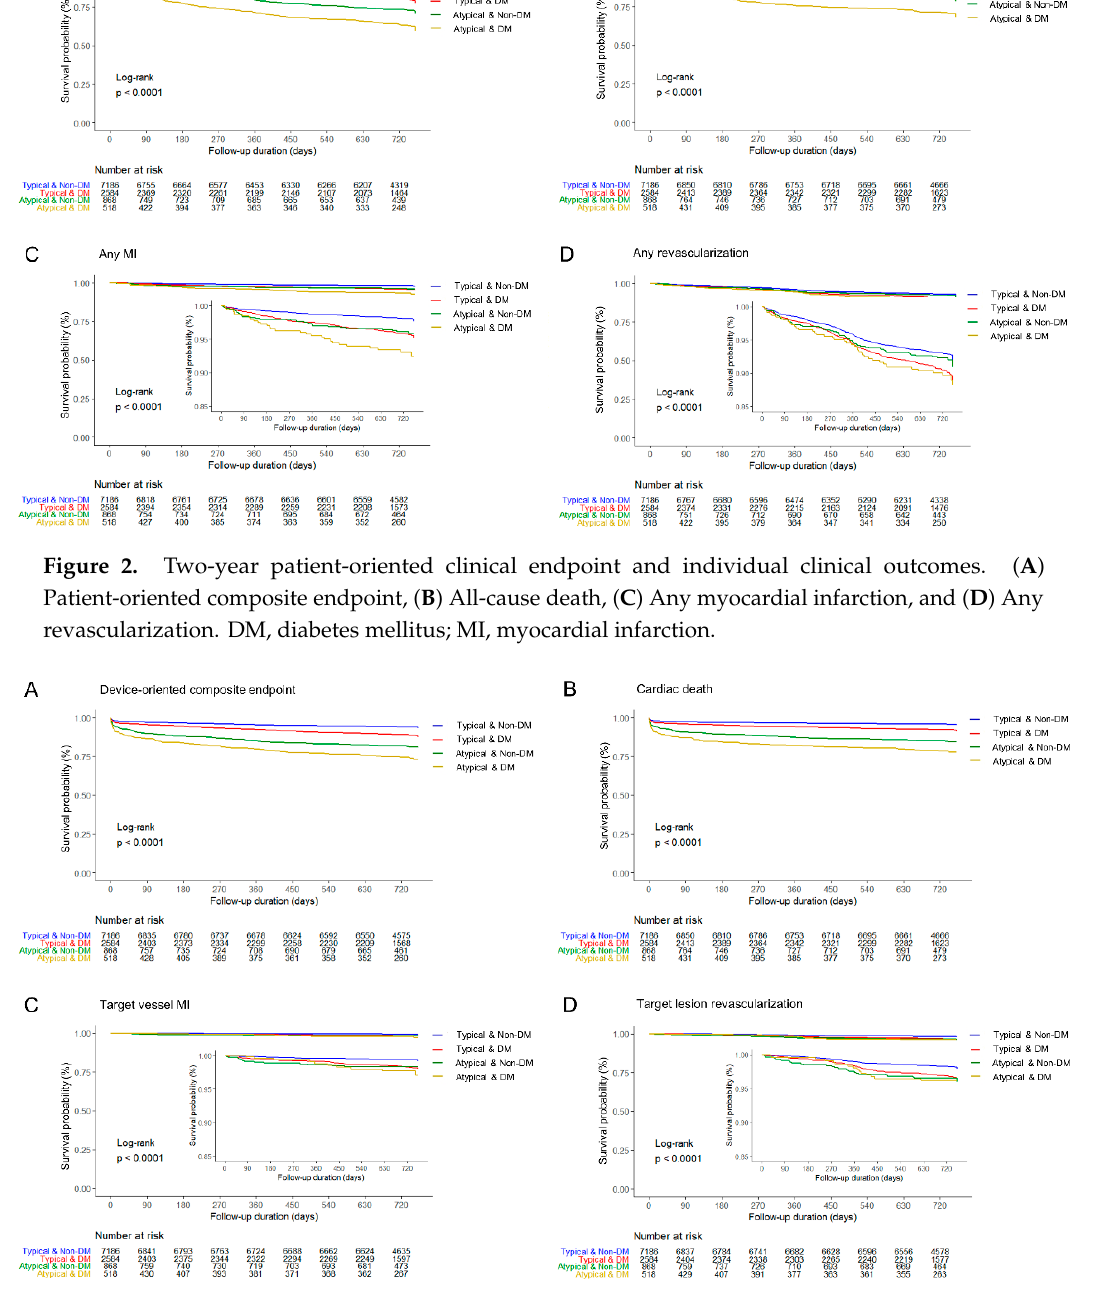
Figure 3. Two-year device-oriented clinical endpoint and individual clinical outcomes. (A) Device-oriented composite endpoint, (B) Cardiac death, (C) Target vessel myocardial infarction, and (D) Target lesion revascularization.DM, diabetes mellitus; MI, myocardial infarction.